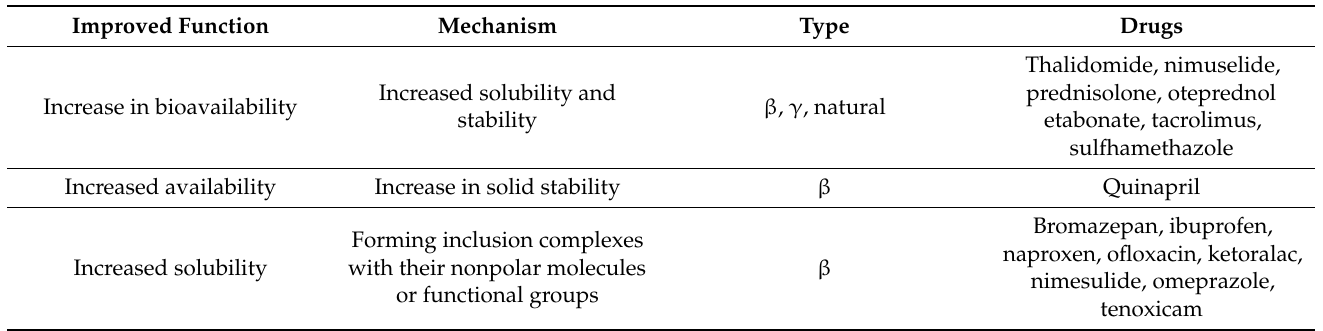
Table 5. Example of some improved drug functions achieved by CDs complexation. Adapted from